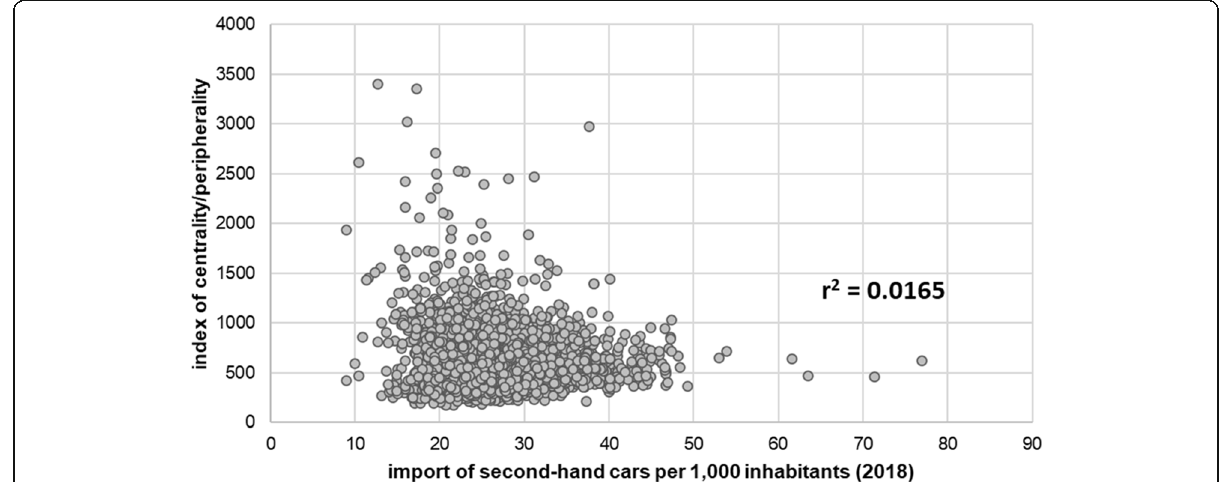
Fig. 6 Relationship between the centrality/peripherality index and the import of second-hand cars. Source: own elaboration based on the Ministry of Finance and Central Vehicle Agency data